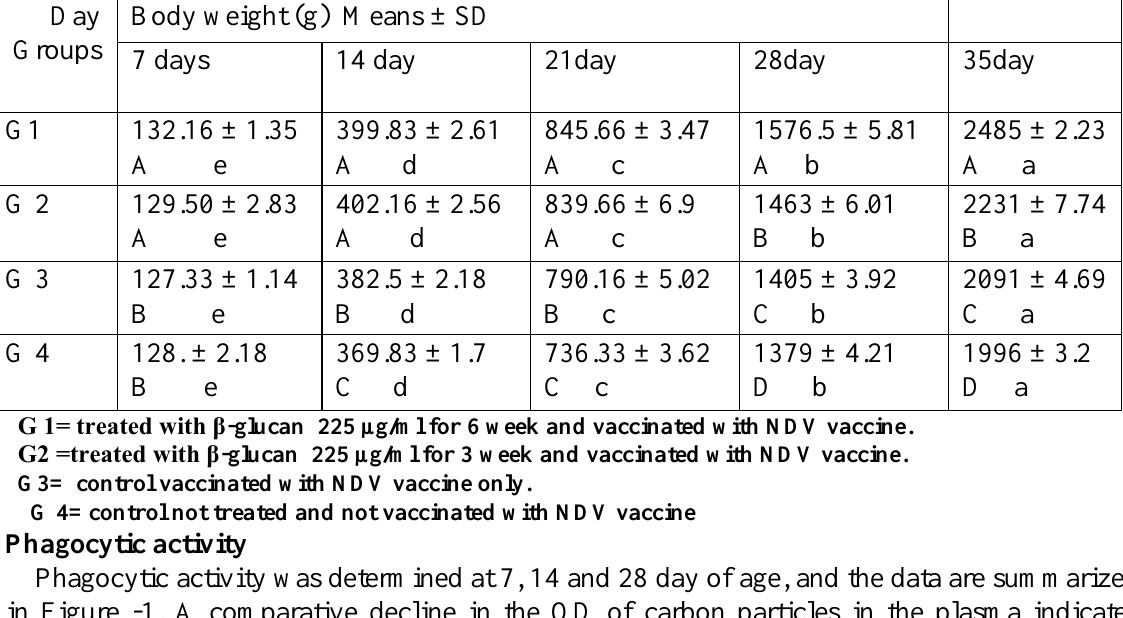
Table- 3: Effect of β-glucan extract on body weight of chicks that supplemented with β- glucan in drinking water as compared to control